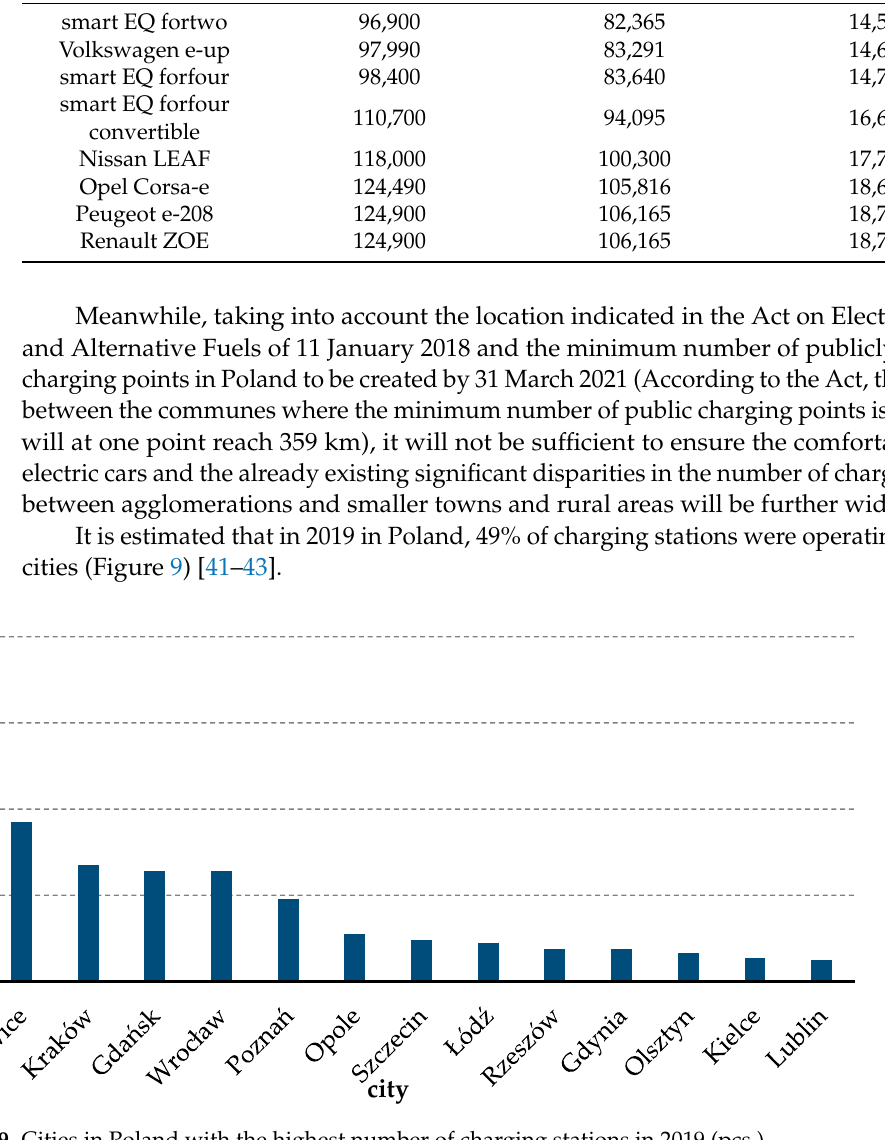
Figure 9. Cities in Poland with the highest number of charging stations in 2019 (pcs.).